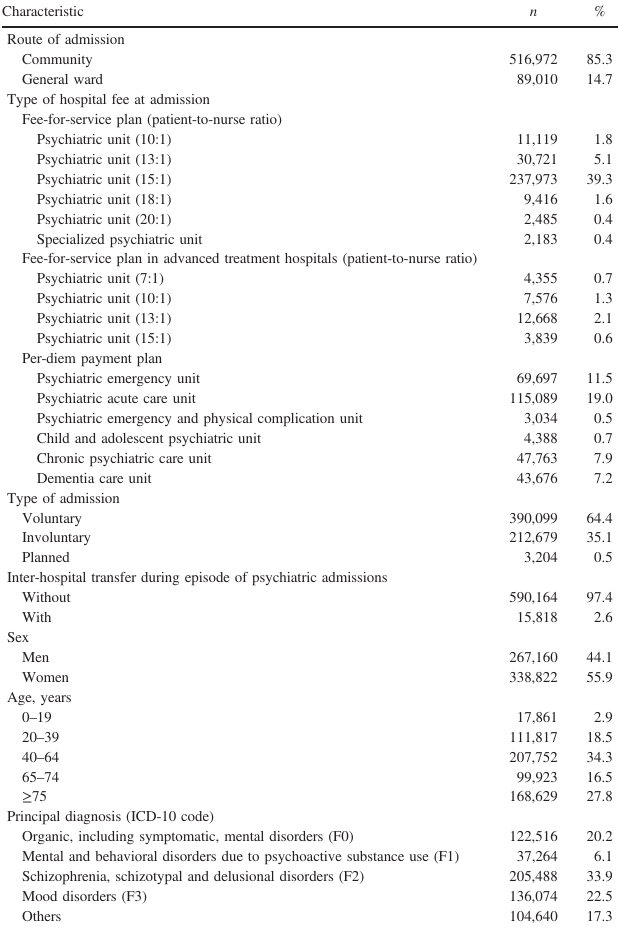
Table 1. Characteristics of study population Characteristic n